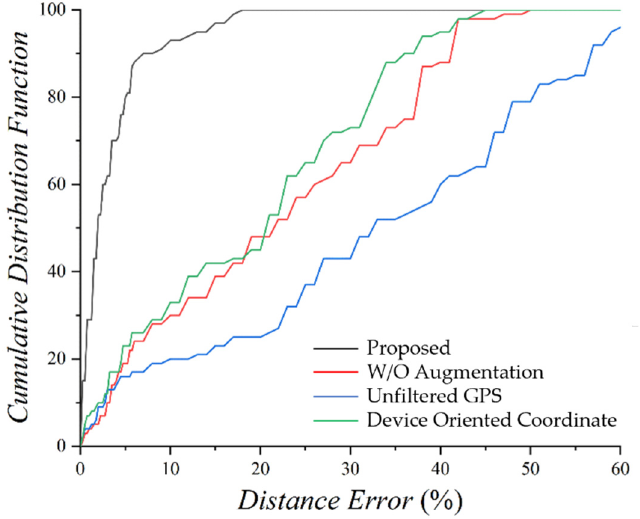
Figure 12. CDF graph of moving speed estimation.